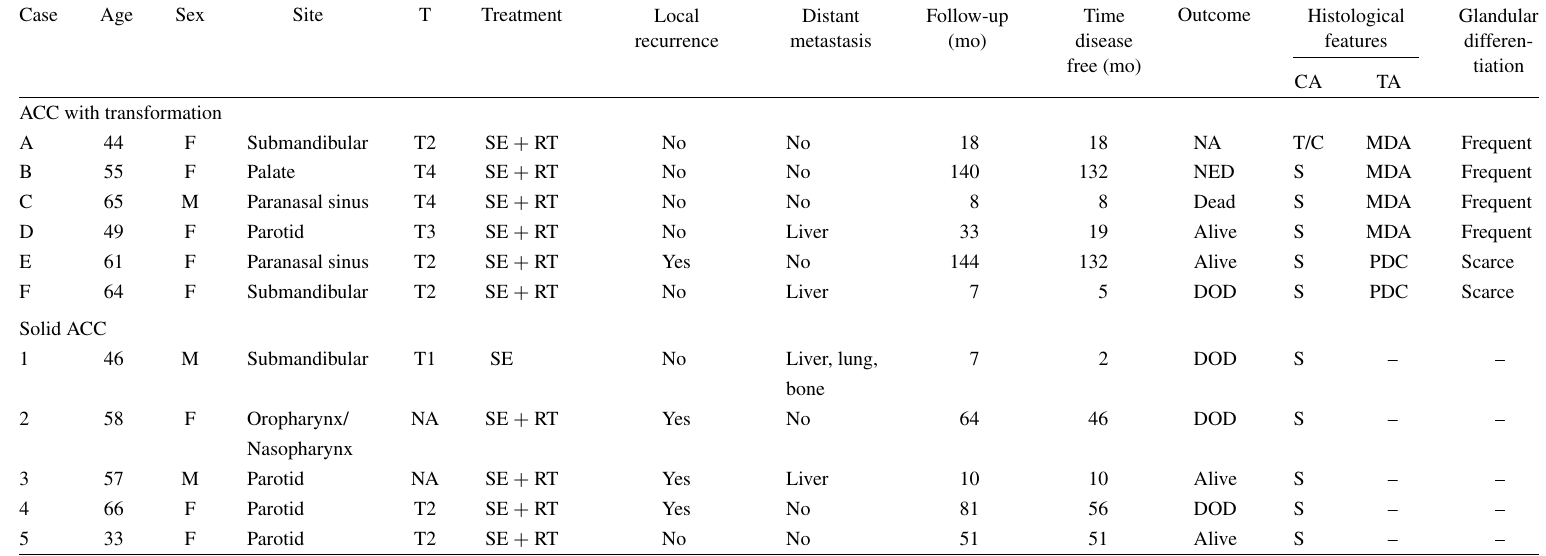
Clinicopathologic